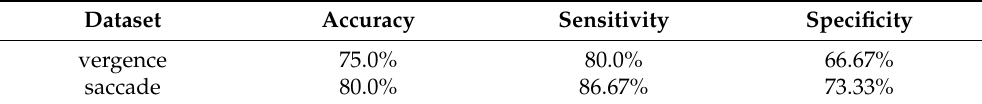
Table 7. Logistic regression scores when using DGI feature on the saccade and vergence